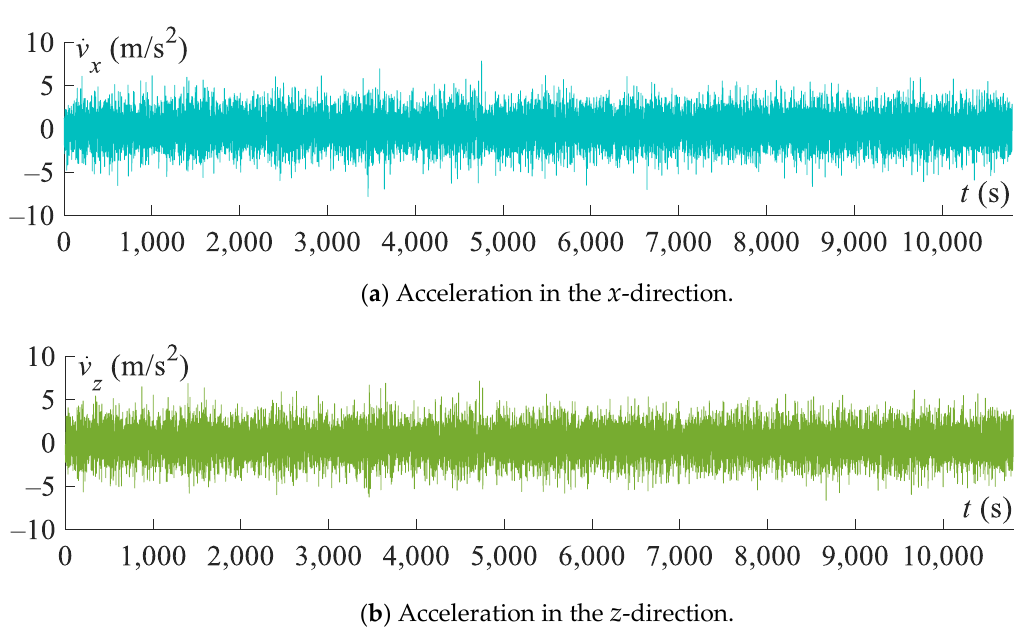
Figure 3. Samples of wave–particle velocities at a still water level ( z = 0).